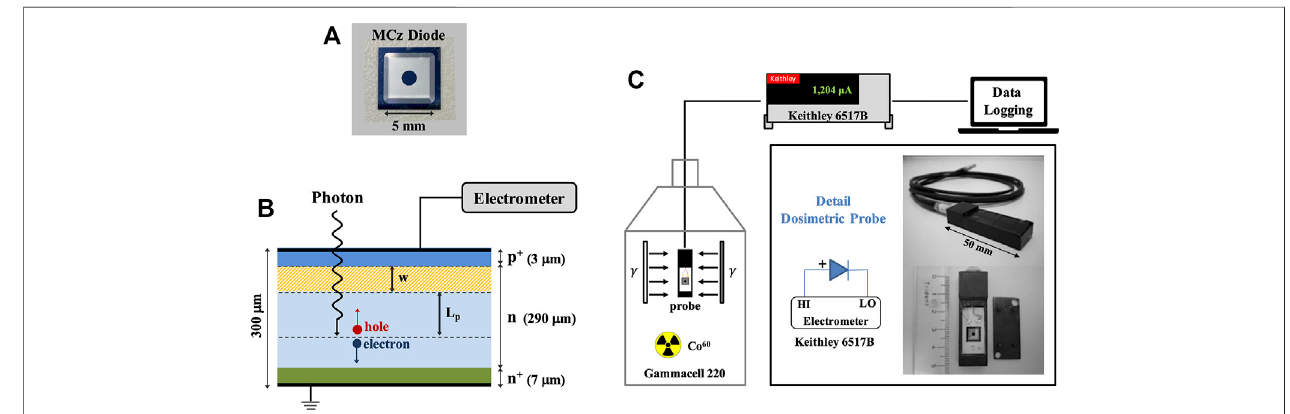
FIGURE 1 | (A) A photograph of the diode; (B) the simpli fi ed structure of the diode in the short-circuit mode, and (C) the schematic diagram of the experimental setup.